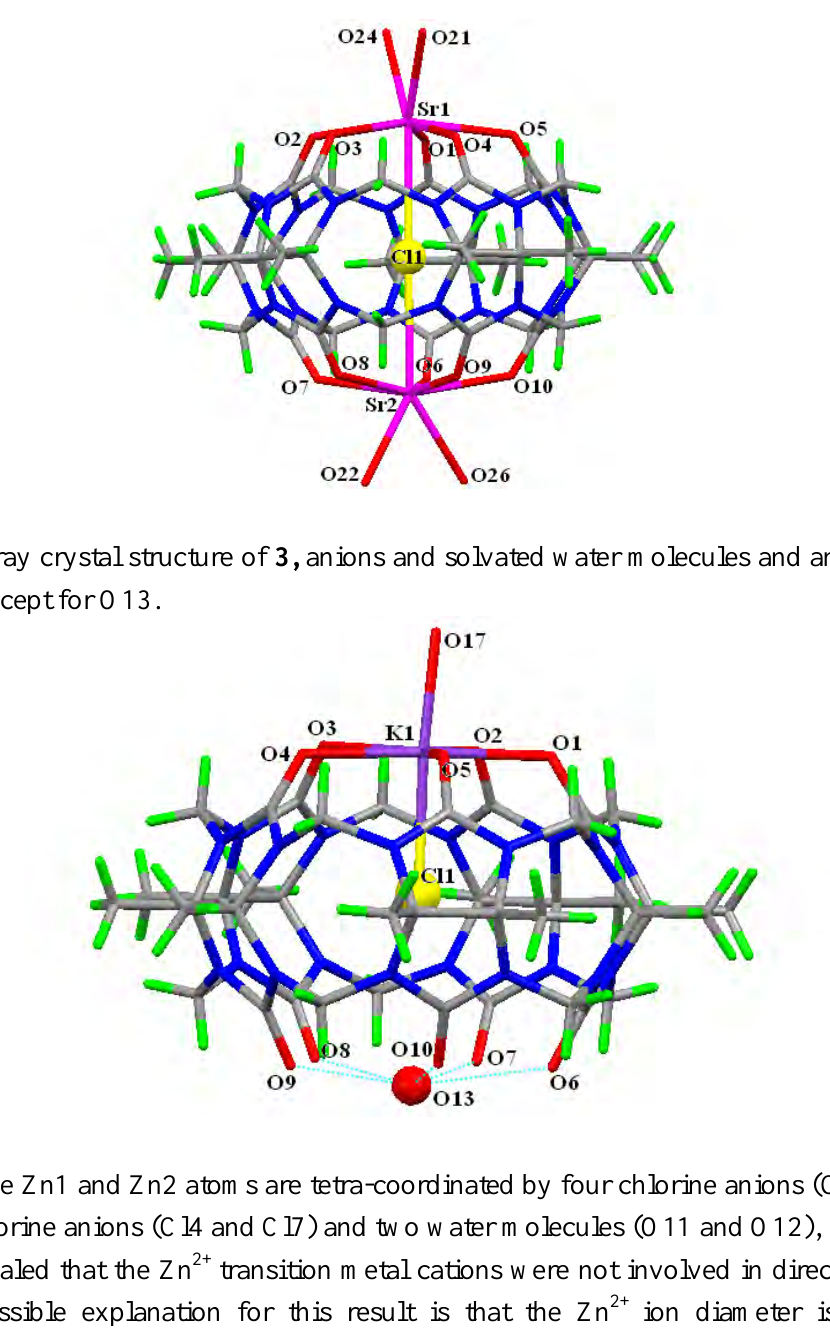
Figure 3. X-ray crystal structure of 2 . Solvated water molecules and anions are omitted for clarity.